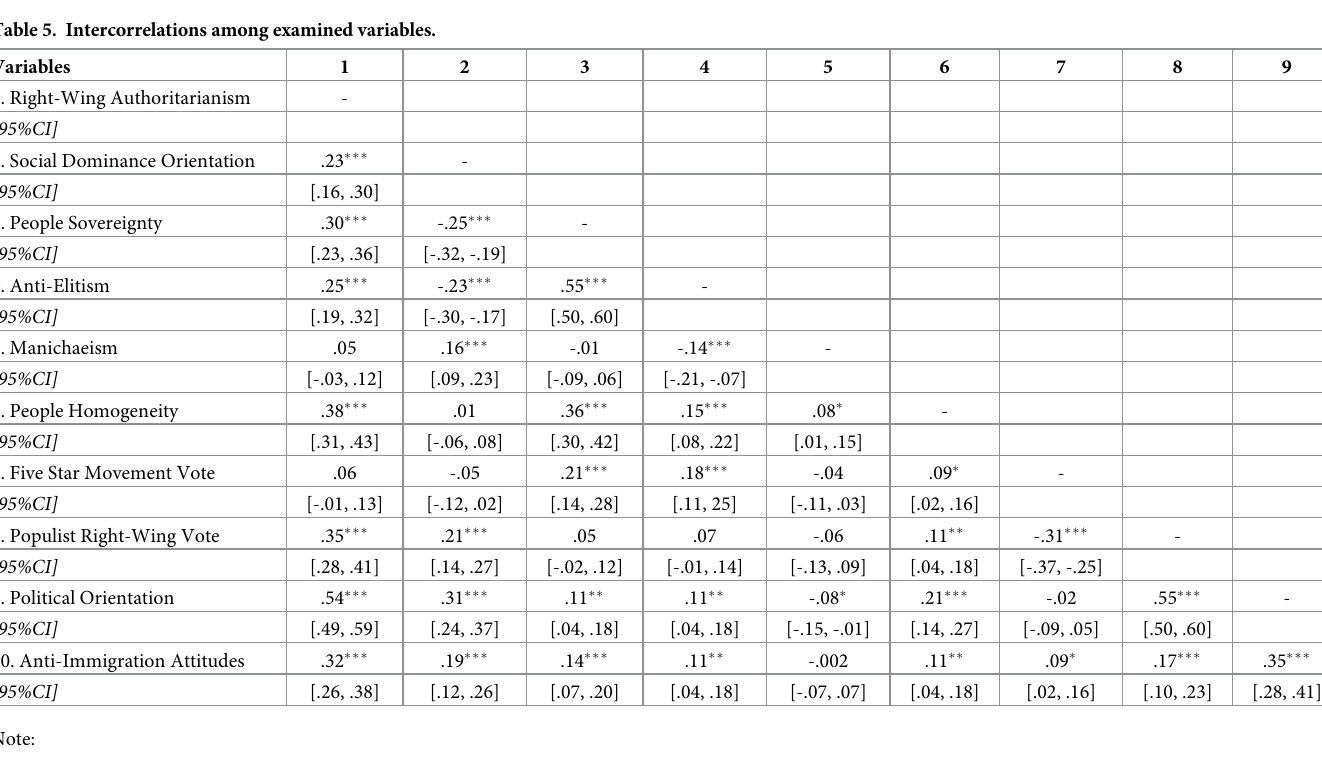
Table 5. Intercorrelations among examined